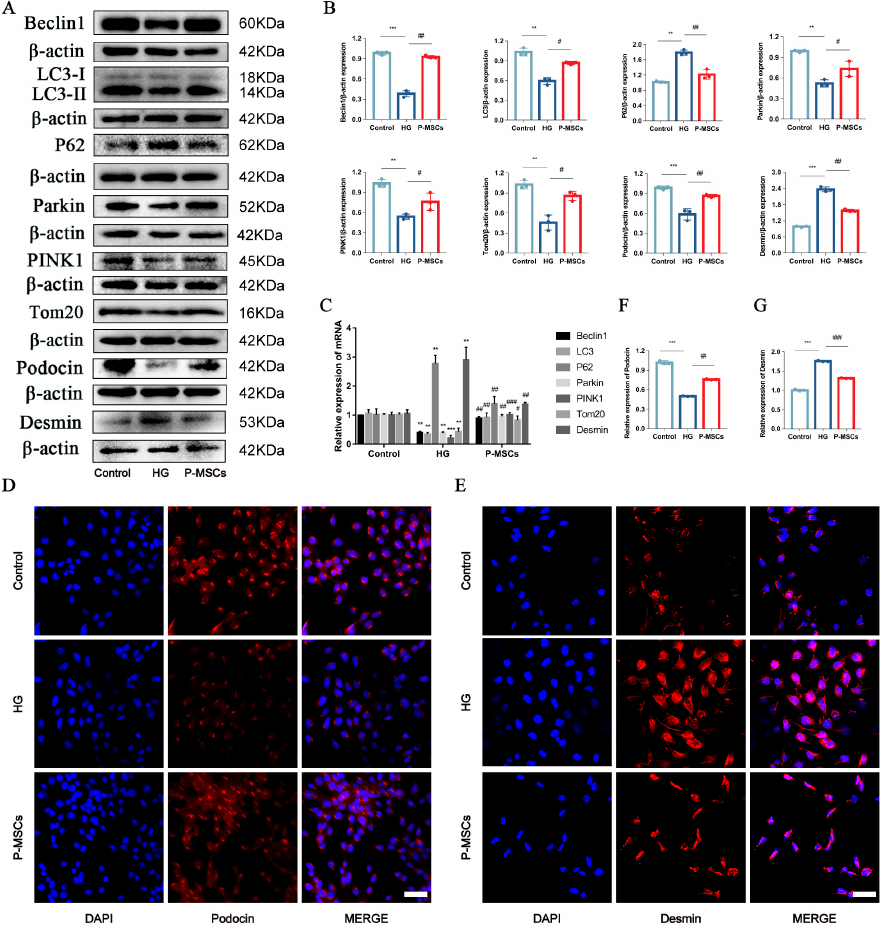
Figure 2. P-MSCs attenuated HG-induced podocyte injury and PINK1/Parkin-mediated mitophagy inhibition. ( A , B ) Representative Western blot analysis of Beclin1, LC3II/LC3I ratio, P62, Parkin, PINK1, and Tom20 as well as Podocin and Desmin in MPC5. © Representative RT ‐ PCR analysis of Beclin1, LC3II/LC3I ratio, P62, Parkin, PINK1, and Tom20, as well as Desmin in MPC5. ( D – G ) Im ‐ munofluorescence staining of Podocin and Desmin in MPC5 (Magnification, 400×). Scale bars: 50 μ m for ( D , E ). n = 3 for ( A – E ). Values are expressed as the mean ± SD. β‐ actin was used as loading control. ** p < 0.01 and *** p < 0.001 vs. control, # p < 0.05, ## p < 0.01, and ### p < 0.01 vs. HG. In addition, we used transmission electron microscopy to observe the structure and quantity of the nuclear membrane, autophagosomes, and lysosomes. As shown in Figure 3A, the nuclear membrane was intact along with more autophagosomes (red arrows) and lysosomes (green arrows) in the control group. However, the integrity of the nuclear membrane was disrupted, and was accompanied by fewer autophagosomes and